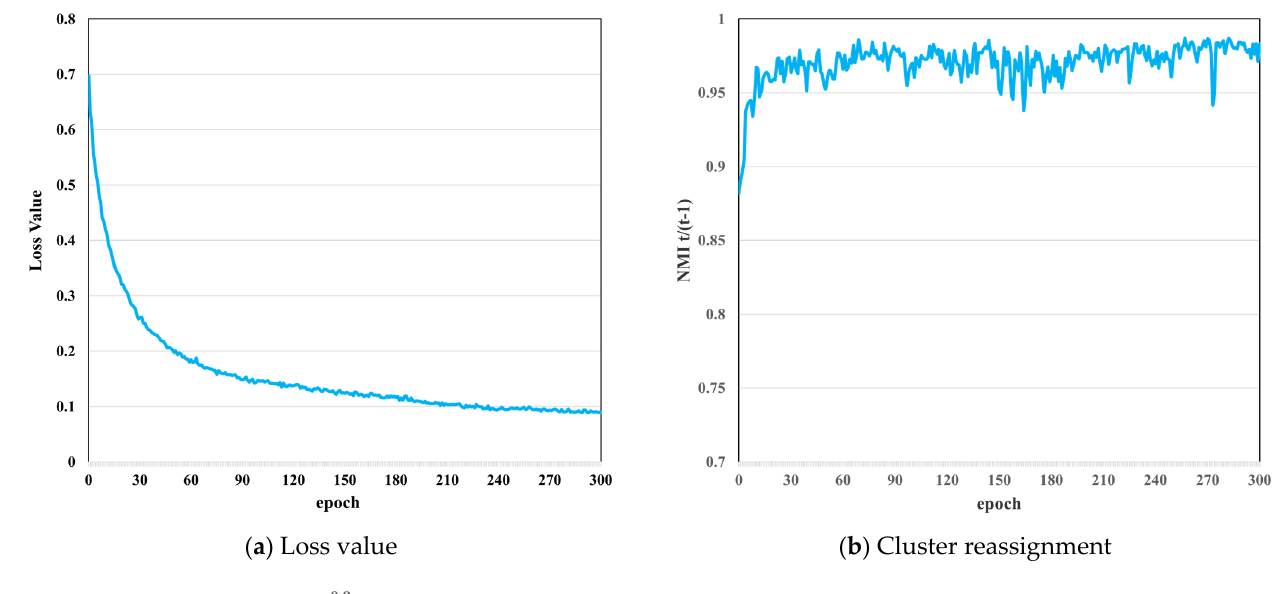
Figure 7. Clustering maps of the Reunion Island Dataset produced using different methods with random initial cluster centers. ( a ) FAISS; ( b ) K-means; ( c ) DTIC; ( d ) reference map.